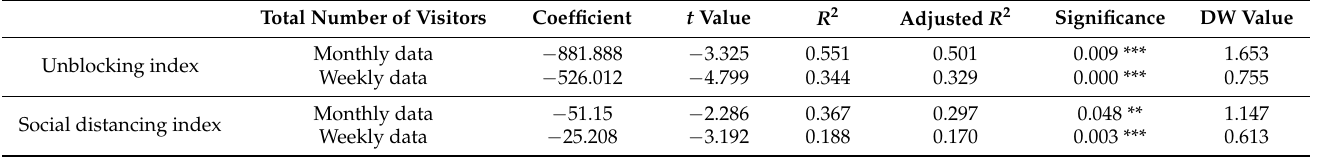
Table 2. The impact of the unblocking index and social distance index on the visitation.